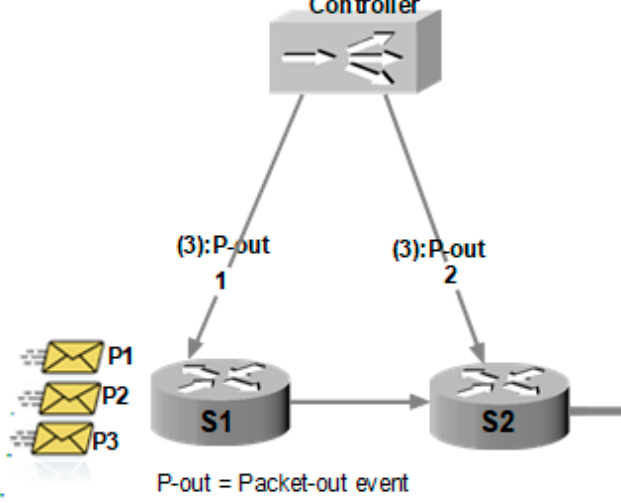
Figure 4. Example of proactive entry installation.